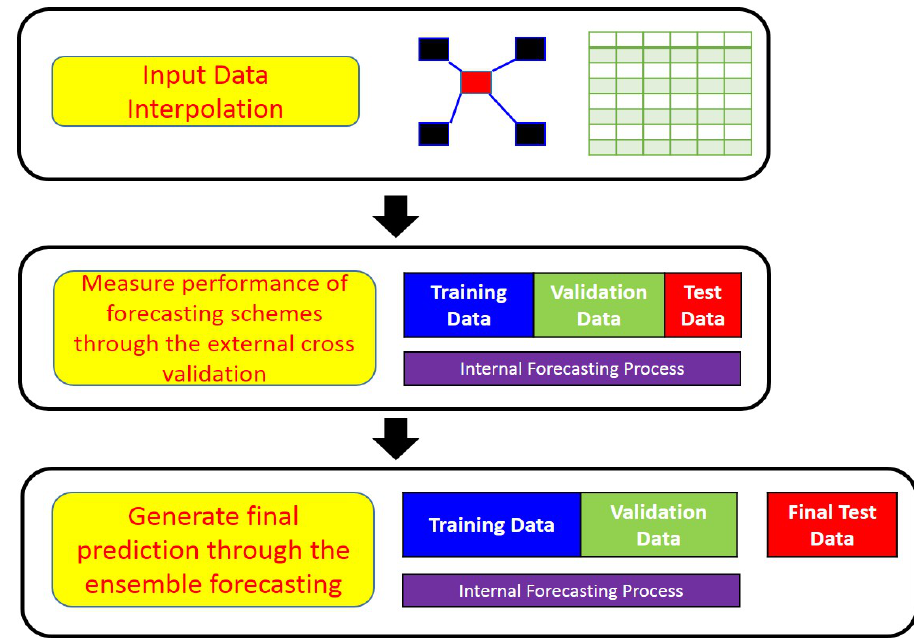
Figure 2. Three steps in the external forecasting process are shown. In the second and third steps, the internal forecasting process in Figure 3 is used.